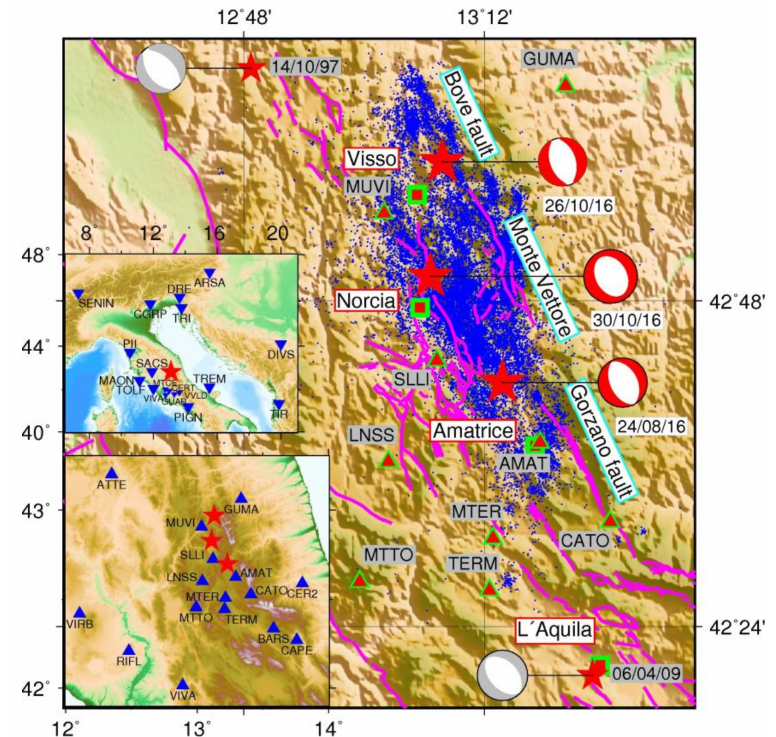
Figure 1. Map of the study area. Red stars, the epicentral location of the three mainshocks together with historical events. Beachballs, Istituto Nazionale di Geofisica e Vulcanologia (INGV) focal mechanisms of the three mainshocks and historical events, respectively. Blue dots, aftershock locations. Magenta lines, main fault extents in this area. Triangles and inversed triangles, high-rate Global Positioning System (GPS) stations and broadband seismometers used in this